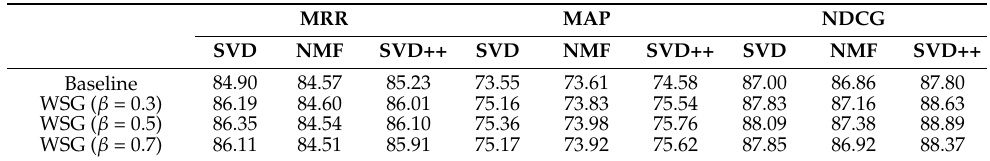
Table 3. MRR, MAP, and NDCG values (%) without and with L-CNN sentiment and genres-based model on Amazon Movie dataset with different β values.